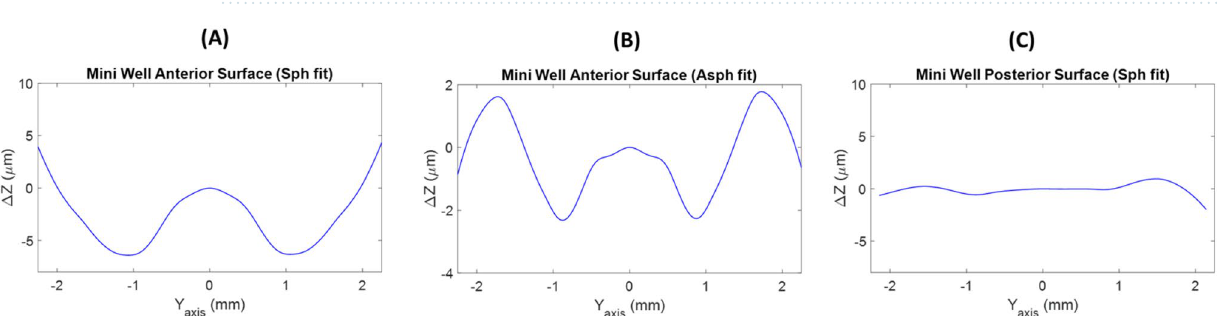
Figure 5. Subtraction lines obtained after the removal of the best-fit sphere ( A ) or asphere ( B ) of the anterior surface and best-fit sphere ( C ) of posterior surface from the smooth profiles of the Eyhance IOL.